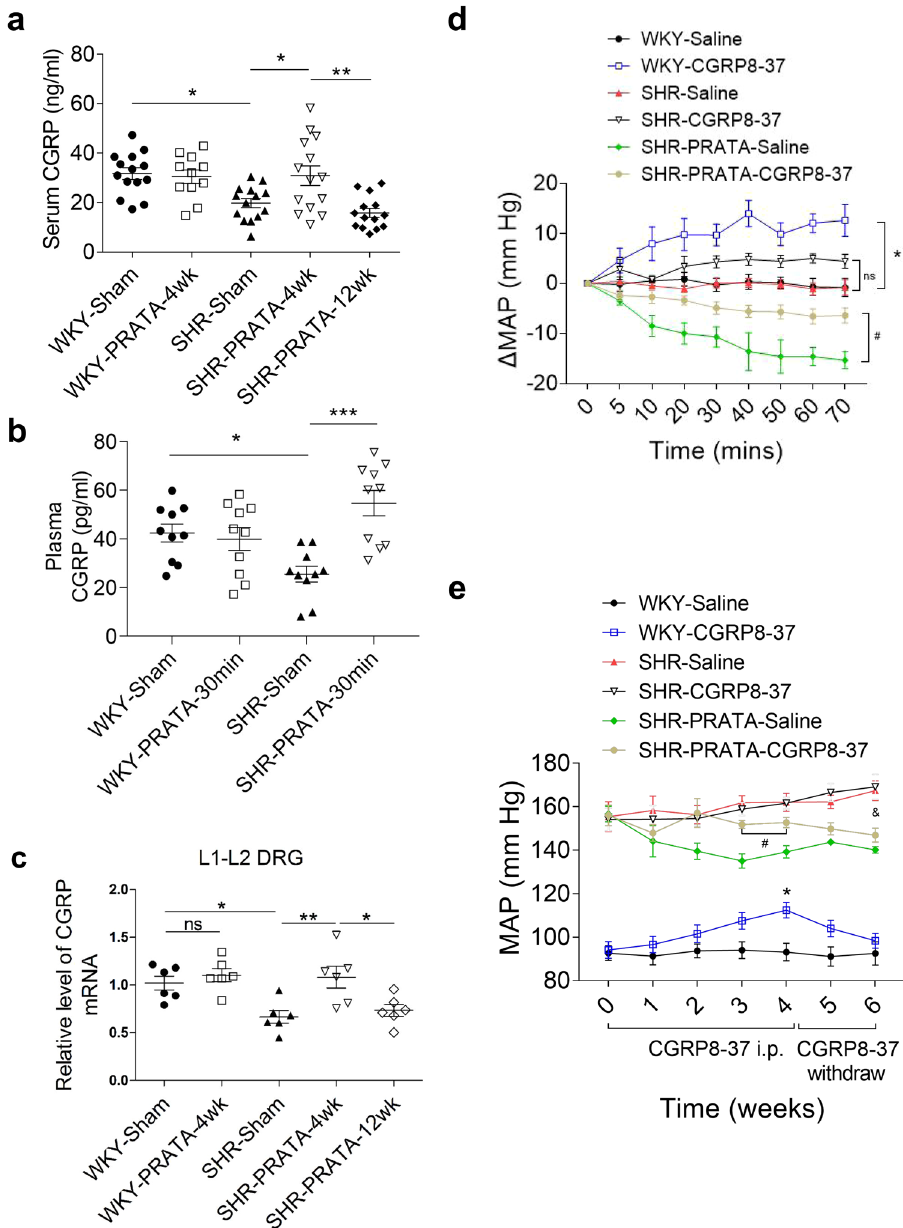
Fig. 6 CGRP as a mediator for BP-lowering effects of PRATA. a , b Serum or plasma levels of CGRP assessed by ELISA post PRATA in chronic ( a ) or acute ( b ) experiments. n = 11 for WKY-PRATA-4wk group, n = 14 for other groups in ( a ). n = 10 per group in ( b ); Data are mean ± SEM. P > 0.05 non-signi fi cant (ns), * P < 0.05, ** P < 0.01, *** P < 0.001. ANOVA, Bonferroni post-hoc test, two-sided. c mRNA levels of CGRP assessed by qPCR in L1 and L2 DRGs post PRATA, n = 6 per group; Data are mean ± SEM, P > 0.05 non-signi fi cant (ns), * P < 0.05, ** P < 0.01. ANOVA, Bonferroni post-hoc test, two-sided. d Changes of the intracarotid arterial MAP post PRATA combined with CGRP8-37 (1 mg/kg) treatment, n = 5 for WKY-Saline, WKY-CGRP8-37, SHR- PRATA-Saline groups, n = 6 for SHR-Saline, SHR-CGRP8-37, SHR-PRATA-CGRP8-37 groups; Data are mean ± SEM. * P < 0.05, WKY-Saline vs. WKY- CGRP8-37; # P < 0.05, SHR-PRATA-Saline vs. SHR-PRATA-CGRP8-37; P > 0.05 non-signi fi cant (ns), SHR-Saline vs. SHR-CGRP8-37. ANOVA, Bonferroni post-hoc test, two-sided. e Weekly measurement of tail arterial BP post PRATA combined with CGRP8-37 (10 μ g/kg/d) treatment, n = 8 for WKY- CGRP8-37 group, n = 7 for other groups; Data are mean ± SEM. * P < 0.05, WKY-Saline vs. WKY-CGRP8-37; # P < 0.05, SHR-PRATA-Saline vs. SHR- PRATA-CGRP8-37; & P < 0.05, SHR-Saline vs. SHR-PRATA-CGRP8-37. ANOVA, Bonferroni post-hoc test,